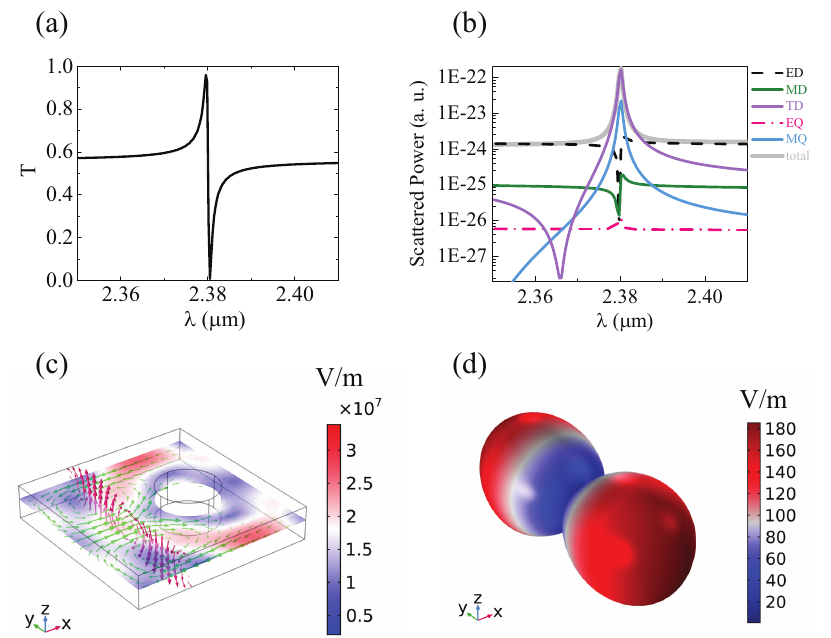
Figure A2. The transmission spectrum, scattered power of different multipole components, electric field distribution, and far-field radiation pattern at the resonant wavelength under the x -polarized